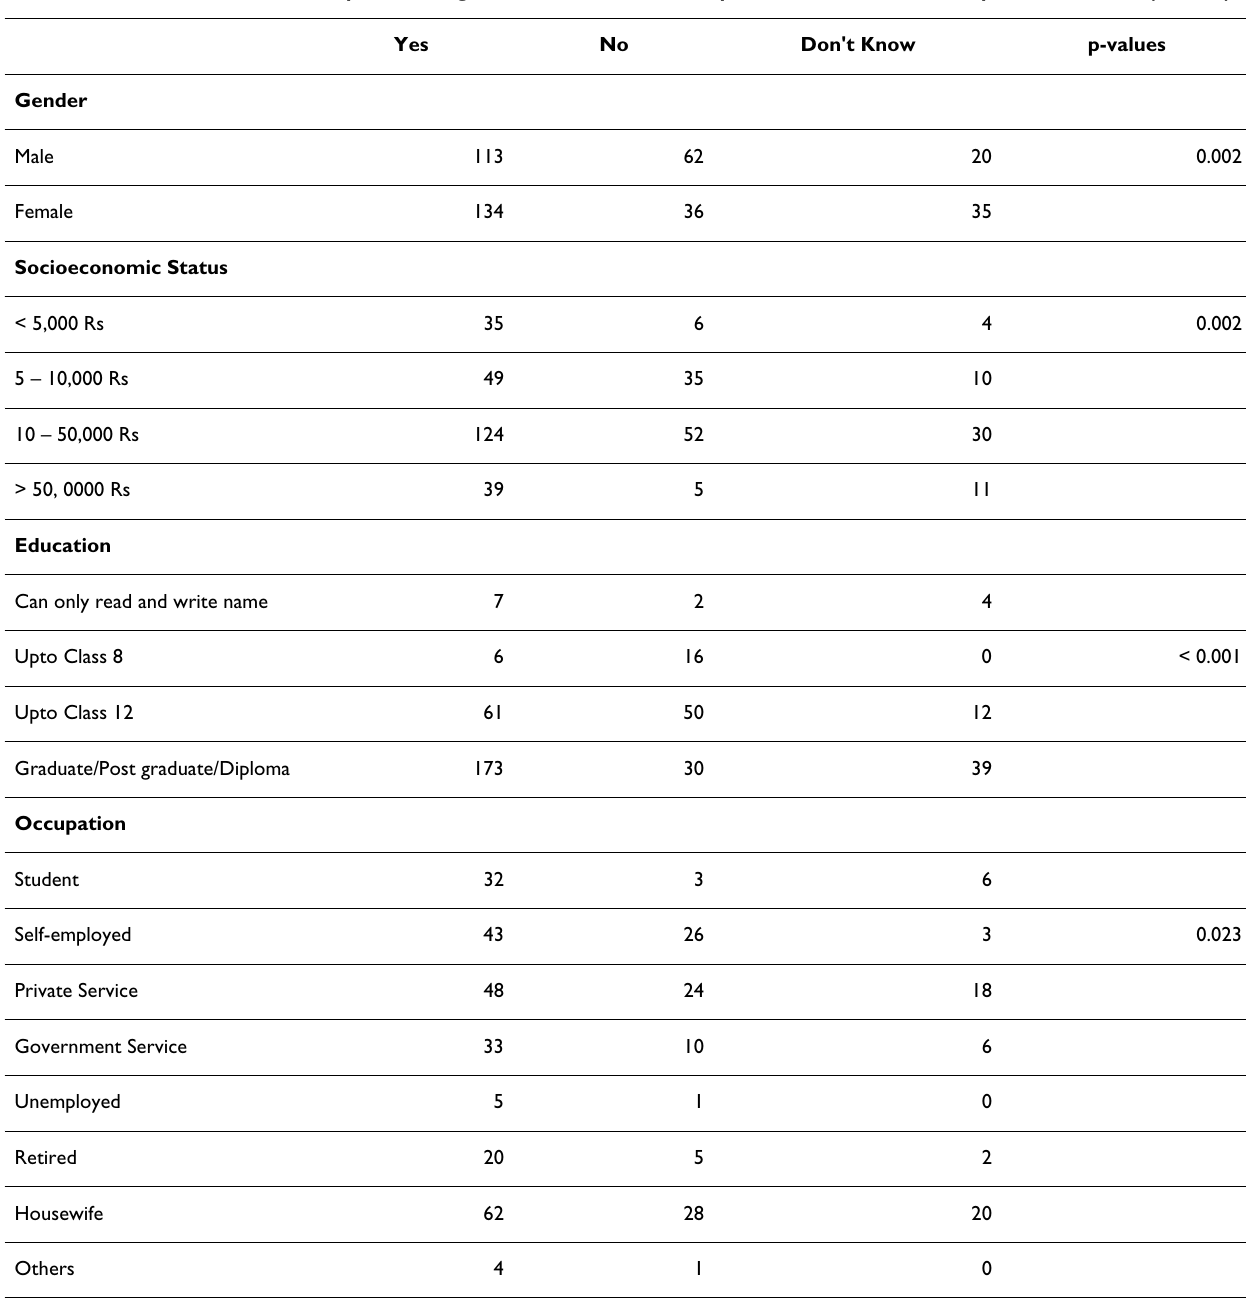
Table 5: Association that gemstone use is based on superstitious beliefs